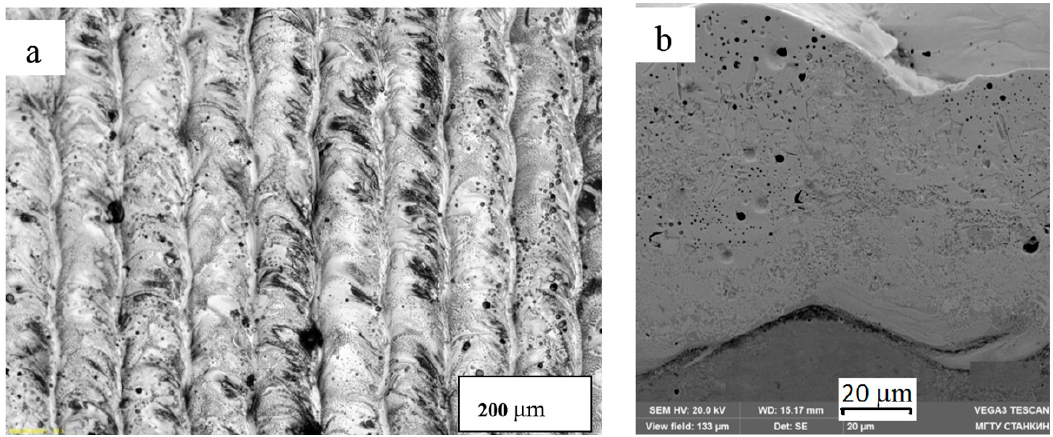
Figure 14. Multilayer WC–Co sample 94%–6%: ( a ) top view, ( b ) cross section.